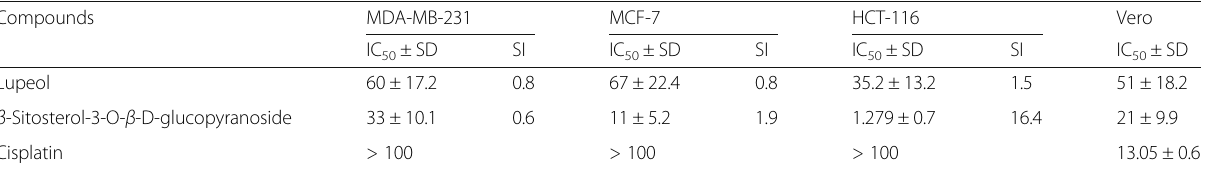
Table 4 In vitro effect of lupeol and β -sitosterol-3-O- β -D-glucopyranoside on the proliferation of human cancer cell lines and non- tumorigenic cell line (Vero cells)